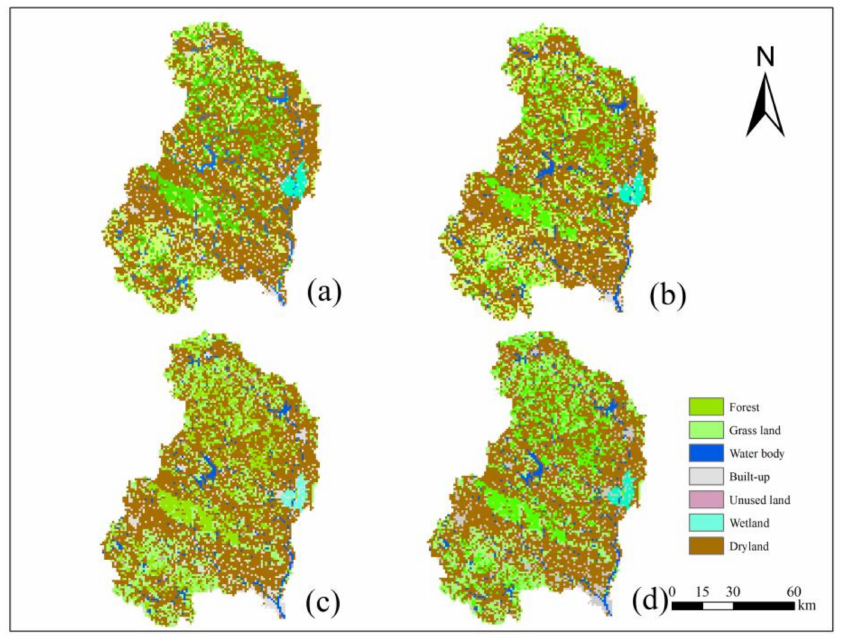
Figure 7. Spatial distribution of the land-use types in 1990 ( a ), 1995 ( b ), 2005 ( c ), and 2015 ( d ). Based on the change rate of the land use, from 1990 to 2015, the increase rate of built-up land was the highest, at 18.96%, followed by that of unused land and water bodies, at 15% and 13.04%, respectively. The wetland reduction rate was the highest, at − 15.38%; the next-highest values were attained for grassland and dryland areas, at − 3.09% and − 1.77%, respectively (Figure